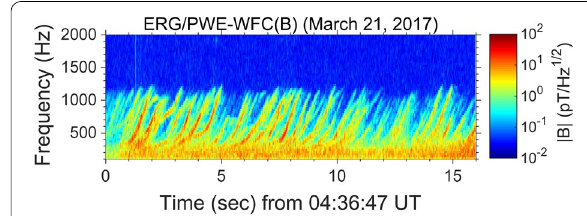
1nT/Hz 1 / 2 ). = Fig. 17 Example of initial observations of chorus waves conducted at 04:36 UT, March 21,